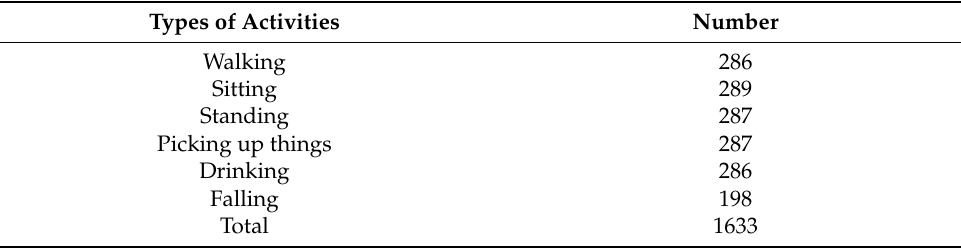
Figure 3. Radar data process showing Time–Velocity patterns. Table 2. Number of samples per activity type.